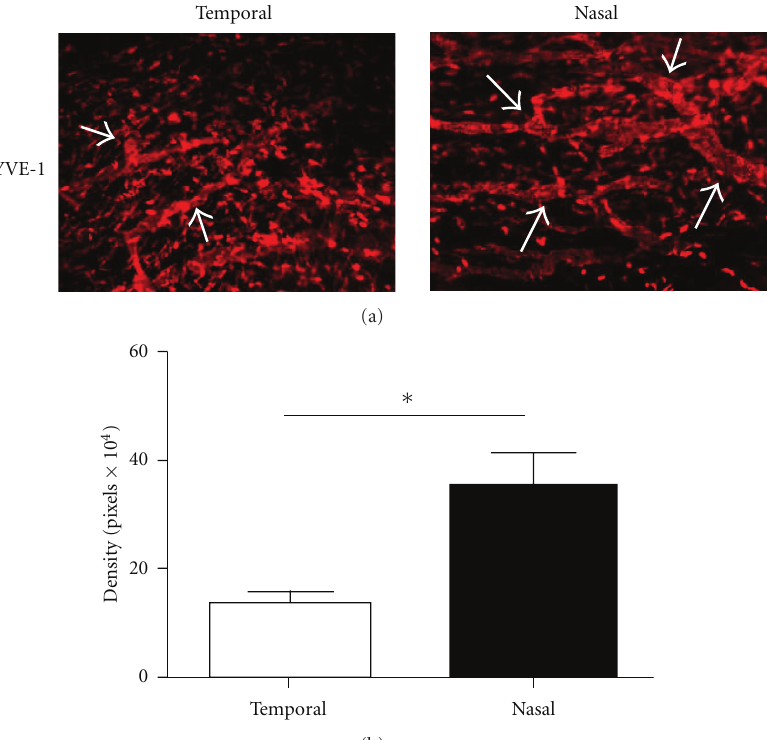
Figure 4: Comparison of conjunctival lymphatic distribution in the nasal versus temporal side of the sutured cornea. (a) Representative immunofluorescent micrographs demonstrating that lymphatic vessels were more prominent in the nasal side. LYVE-1: red; Original Magnification: × 50. (b) Summary of repetitive experiments. ∗ P < 0 .